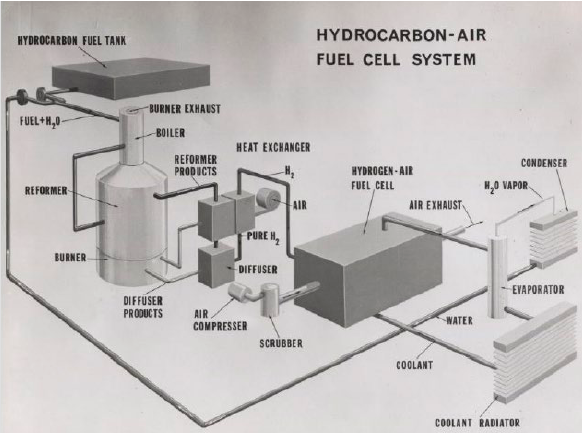
Figure 11. Diagram of fuel cell system. Courtesy of US Army Engi- neer Research & Development